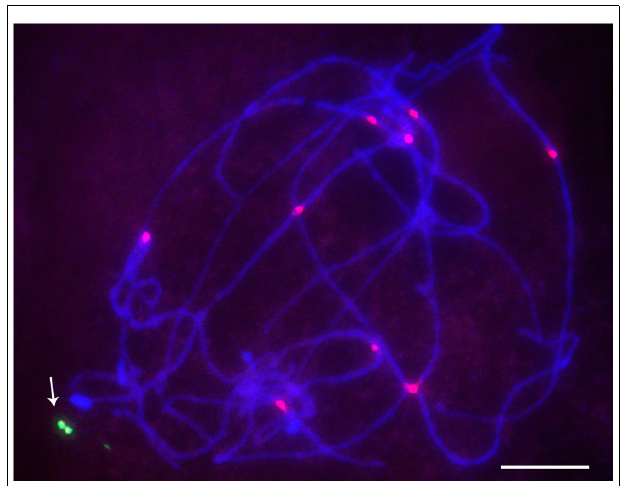
FIGURE 2 | Pachytene stage with minichromosome revealed by FISH. Red is CRM, the maize centromeric retrotransposon, and green is the B-specific sequence (ZmBs); arrow indicates the dicentric minichromosome. Bars = 10 μ m.